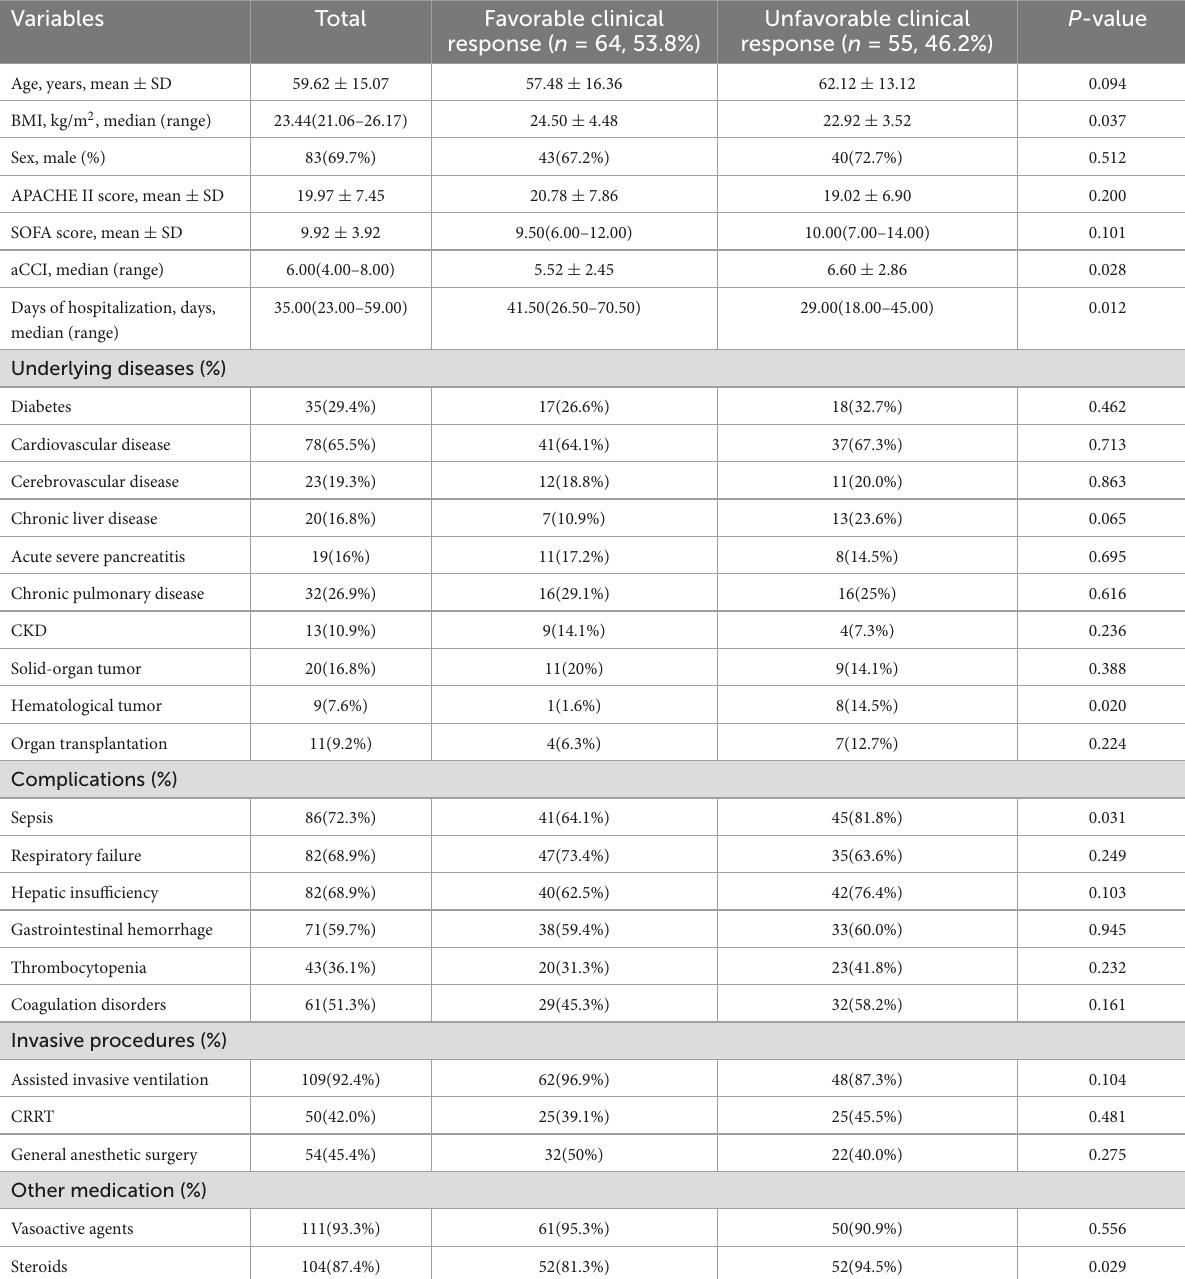
TABLE 1 Demographics and clinical characteristics of 119 patients receiving polymyxin E sulfate.